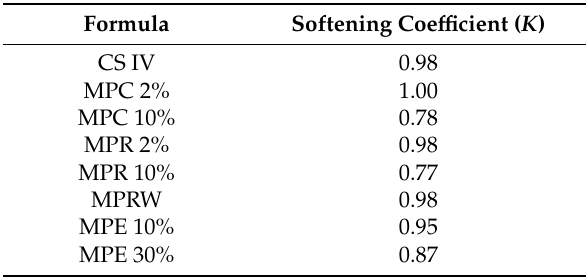
Table 2. Average values of the softening coe ffi